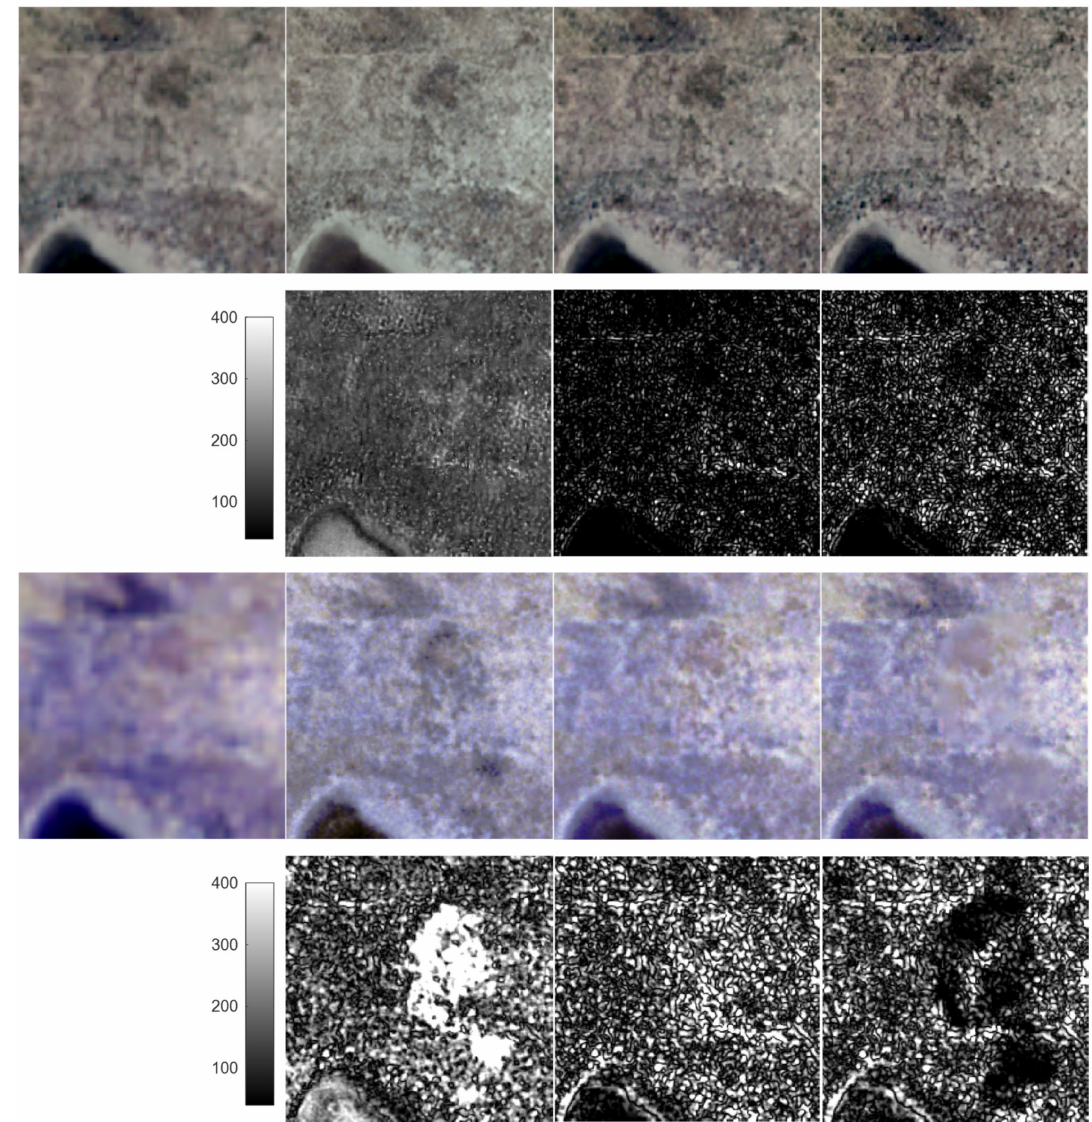
Figure 9. Study site 3 spatial subset (240 × 240 3.333 m pixels, 0.8 × 0.8 km), top row: true color (red, green, and blue) surface reflectance, third row: false color (NIR 855–875 nm, red-edge 773–793 nm, and SWIR 1565–1655 nm) surface reflectance. The columns show from left to right: Sentinel-2 surface reflectance bilinear resampled to 3.333 m, Planetscope-0 3.333 m surface reflectance, HPM sharpened 3.333 m surface reflectance, and M3 sharpened 3.333 m surface reflectance. The second and fourth rows (greyscale figures) show the root mean square di ff erence (RMSD = between the Sentinel-2 bilinear resampled reflectance ( ρ λ , bilinear , left column) and the Planetscope-0 3.333 m, HPM, and M3 sharpened reflectance ( ρ λ , x , shown in the three right columns). RMSD values are scaled in reflectance units (0–1) multiplied by 10,000.